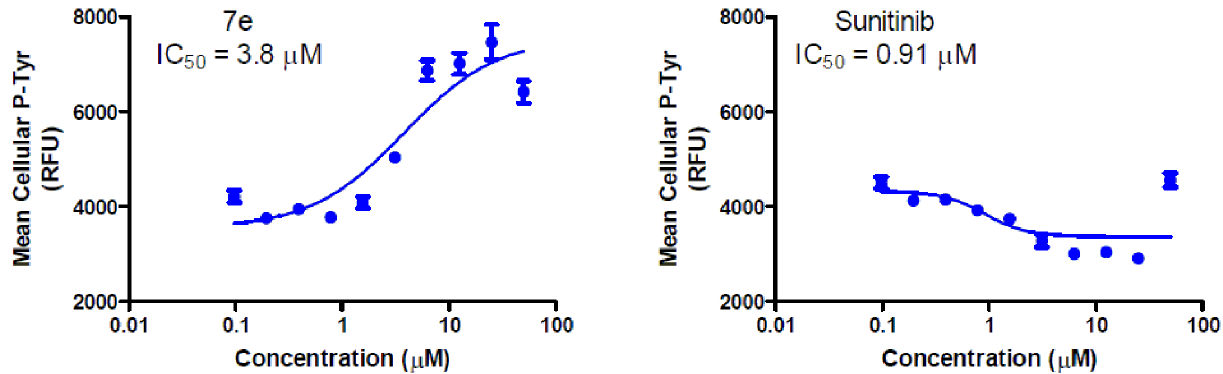
Fig 6. Dose-dependent changes in total levels of tyrosine phosphorylation. Cells were stimulatedfor 10 min with 10% fetal bovine serum. Phosphotyrosine levels were determined by indirect immunofluorescencefollowedby automatedimage acquisitionand analysis.